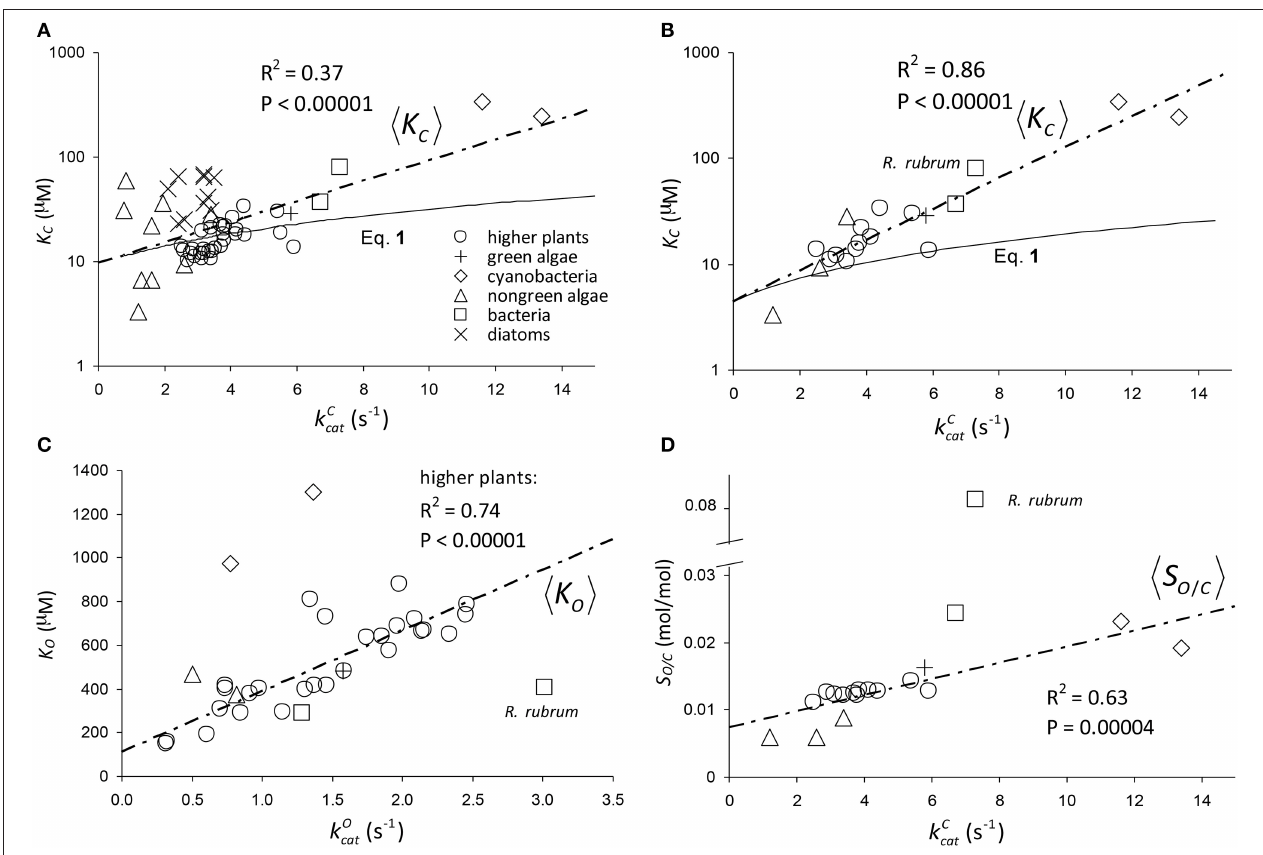
FIGURE 2 | Regression of: (A) K C on k C cat using all data ( Table 1 ) in the regression. The parameters of the exponential, a 1 e b 1 k C cat , are a 1 = 9.7 µ M and b 1 = 0.23s. (B) K C on k C cat using only the data compiled by Savir et al. (2010) in the regression. The parameters of the exponential are a 1 = 4.5 µ M and b 1 = 0.34s. The Form II RuBisCO, R. rubrum , is not a significant outlier. (C) K O on k O cat using all higher plant data ( Table 1 ) only. The gradient and intercept of the regression line are 278 µ M.s and 114 µ M, respectively. Form II RuBisCO, R. rubrum , and the cyanobacteria are the significant outliers by the ESD test with P = 0.05 ( Rosner, 1983). (D) Reciprocal ) on k C cat using the data compiled by Savir et al. (2010). The Form II RuBisCO, R. rubrum is the only significant outlier by the ESD test relative specificity ( S O / C = 1 S C / O O cat ( P = 0.05), due mainly to its relatively higher value for S O = k K O ( Figure 2C ), and was not included in the regression. The gradient and intercept are 1.2 × 10 7.4 × 10 − 3 mol/mol, respectively. Note that in (A,B) K C is graphed in logarithmic scale and Equation (1) has been graphed using the parameters at k C cat = 0 as derived from the regression analysis (see